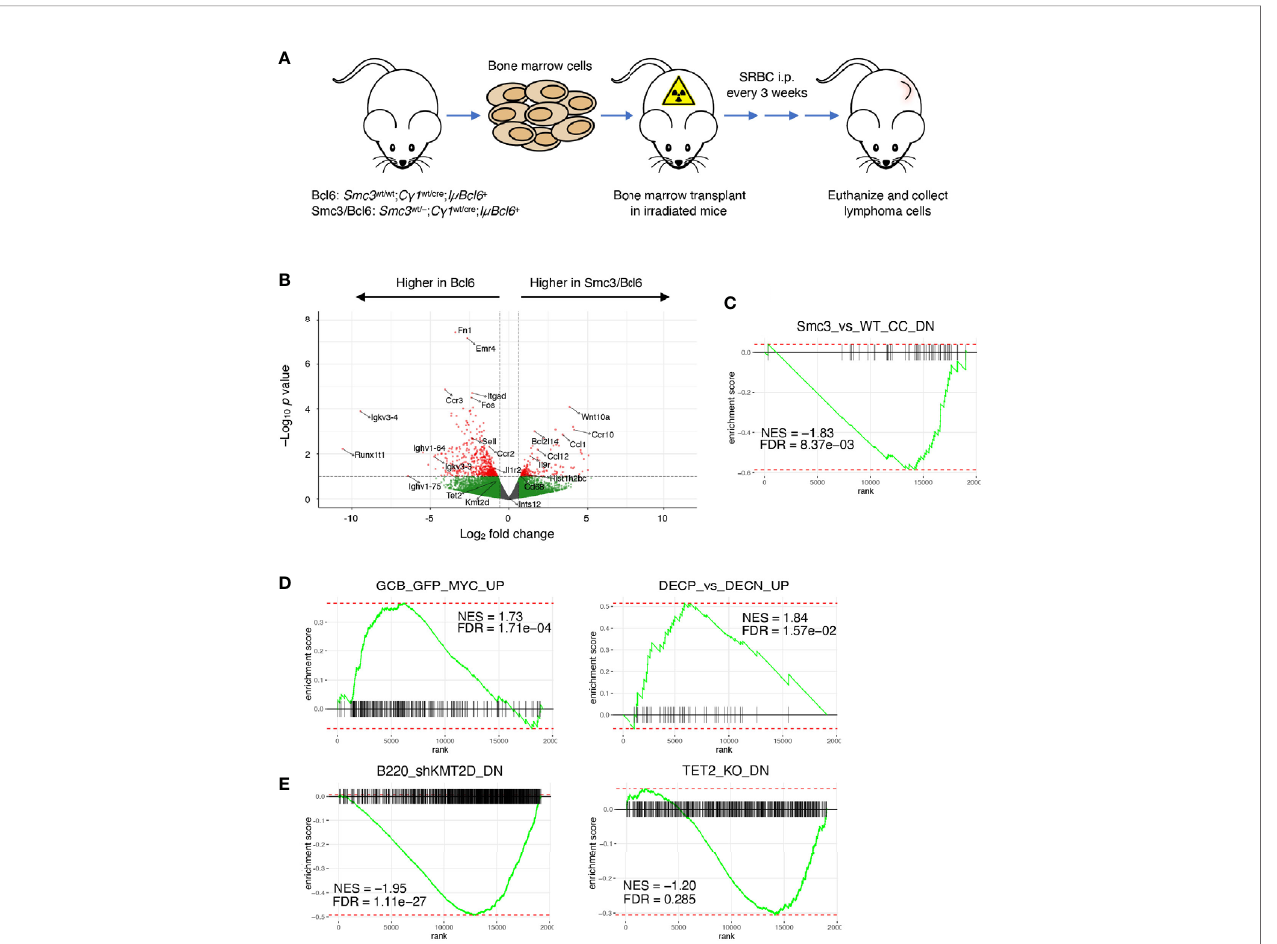
FIGURE 1 | Aberrant gene expression program in Smc3 haploinsuf fi cient tumors. (A) Development and experimental design for study of lymphomas in Bcl6 and Smc3/Bcl6 mice, where conditional heterozygous deletion of Smc3 was directed towards B-cells entering the GC reaction by crossing to the C g 1-Cre strain. (B) Volcano plot showing differentially expressed genes in Bcl6 and Smc3/Bcl6 tumor cell RNA-sequencing. (C – E) Gene set enrichment analysis plots in Bcl6 vs Smc3/Bcl6 RNA-sequencing. Smc3_ vs _WT_CC_DN (6), DECP_ vs _DECN_UP, GCB_GFP_MYC_UP (39), B220_shKMT2D_DN (43) and TET2_KO_DN